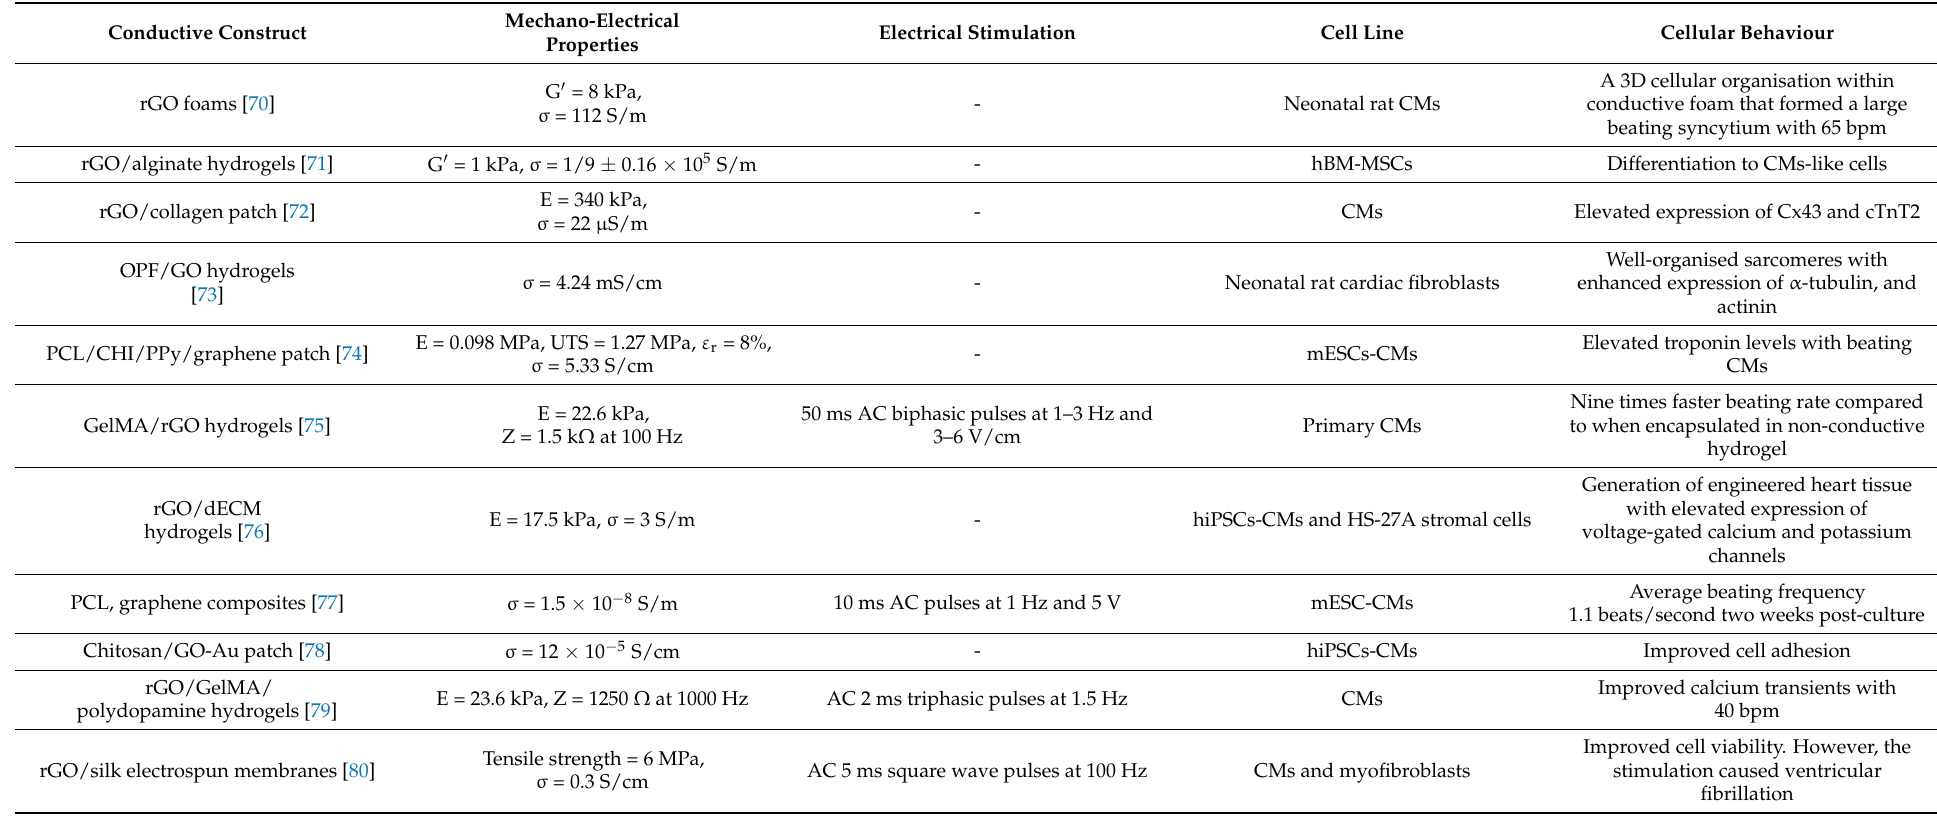
Table 2. Graphene based conductive constructs for cardiac tissue engineering